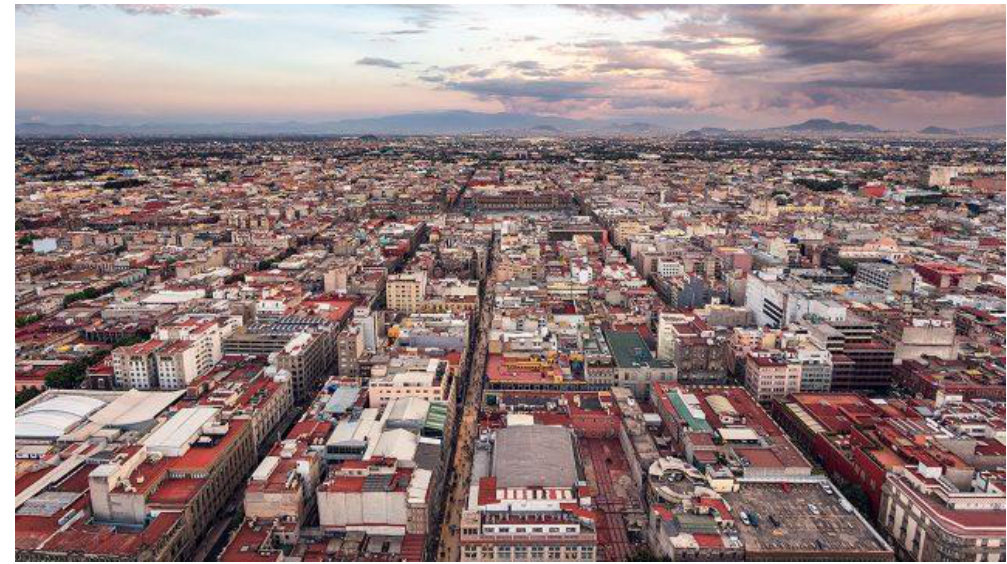
Figure 6. General overview of the Mexico City urban layout (source: gettyimages.com).